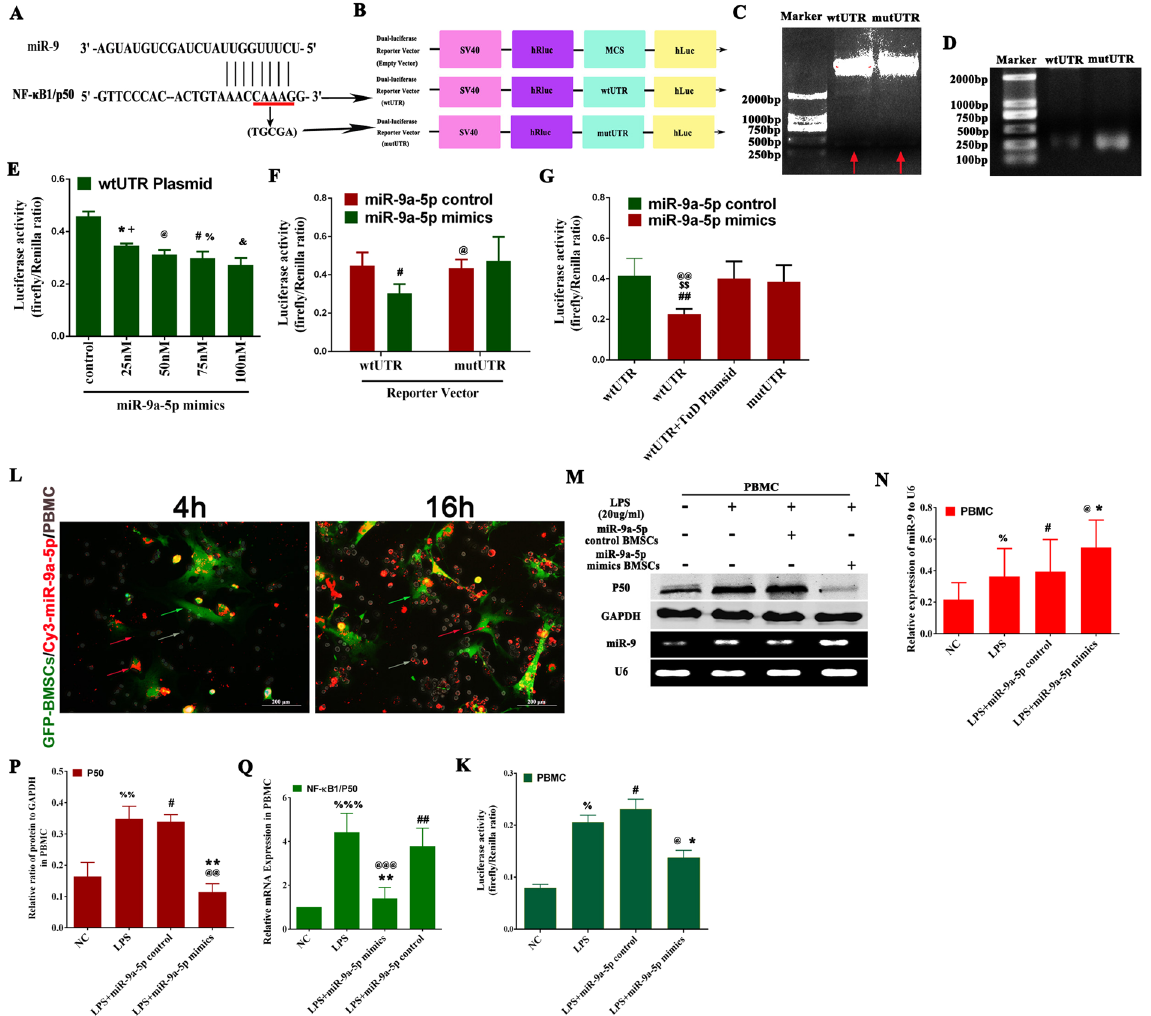
Figure 6. BMSCs could transfer exogenous miR-9 to PBMC, which inhibited the expression of NF- κ B1/p50 gene. ( A ) Eight paired base between miR-9 and NF- κ B1/p50. ( B ) The structure of dual luciferase reporter vector-psiCHECK-2 (Promega, Beijing, China) and the wide-type NF- κ B1 3 ′ UTR (wtUTR) harboring the predicted binding sites of miR-9 and the mutant NF- κ B1 3 ′ UTR (CAAAG → TGCGA) (mutUTR) were cloned into psiCHECK-2 to generate the recombinant vectors of wtUTR- and mutUTR- psiCHECK-2. ( C ) The recombinant plasmids of wtUTR-/mutUTR-psiCHECK-2 were identified by double enzyme digestion. ( D ) The sequence of NF- κ B1 3 ′ UTR (319 bp) was amplified by gPCR from wtUTR- and mutUTR- psiCHECK-2. ( E ) miR-9a-5p mimics could reduce the activity of firefly luciferase with a dose-effect relationship. Data are shown as mean ± SD for at least 3 separate experiments. * p < 0.05, compared with control (con), + p < 0.05, compared with 50 nM, # p < 0.05, compared with con, % p < 0.05, compared with 100 nM, & p < 0.05, compared with con by using paired t test. ( F ) The activity of firefly luciferase could be significantly repressed by miR-9a-5p mimics, but rescued by the mutation of NF- κ B1 3 ′ UTR. # p < 0.05 and @ p > 0.05, compared with miR-9a-5p control by using paired t test. ( G ) The miR-9’s inhibitory effect on the activity of firefly luciferase disappeared after co- transfection with TuD plasmid. Data are shown as mean ± SD for at least 3 separate experiments. ## p < 0.01, compared with miR-9a-5p control. $$ p < 0.01, compared with miR-9a-5p mimics + TuD plasmid, @@ p < 0.01, compared with mutUTR plasmid by using paired t test. ( L ) The GFP-BMSCs (Green) of Cy3-miR-9a-5p mimics (Red) transfection were co-cultured with PBMC (Gray) and 16 hr later, the exogenous Cy3-miR-9a-5p could be observed to be transferred into PBMC as indicated by the red arrow. ( M,N,P,Q,K ) miR-9a-5p mimics could inhibit the expression of NF- κ B1/p50 and reduce the activity of firefly luciferase in LPS-activated PBMC. Data are shown as mean ± SD for at least 3 separate experiments. % P < 0.05 and %% P < 0.01, compared with NC, # p < 0.05, ## p < 0.01 and ## p < 0.01, compared with NC, * p < 0.05 and ** p < 0.01, compared with LPS, @ p < 0.05, @@ p < 0.01 and @@@ p < 0.001, compared with miR-9a-5p control by using paired t